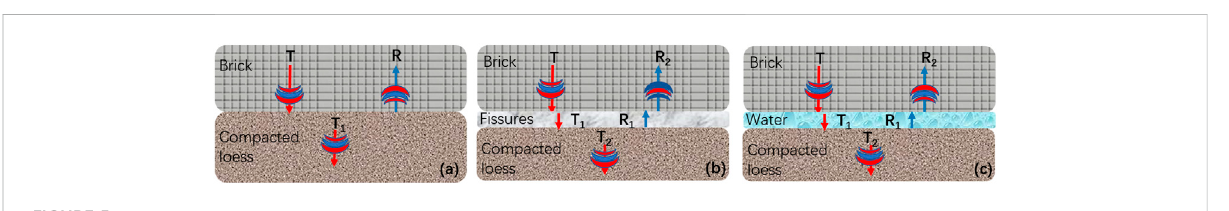
FIGURE 5 Propagation law of electromagnetic waves in (A) brick and compacted loess; (B) brick and compacted loess with fi ssures; and (C) brick and compacted loess with water fi